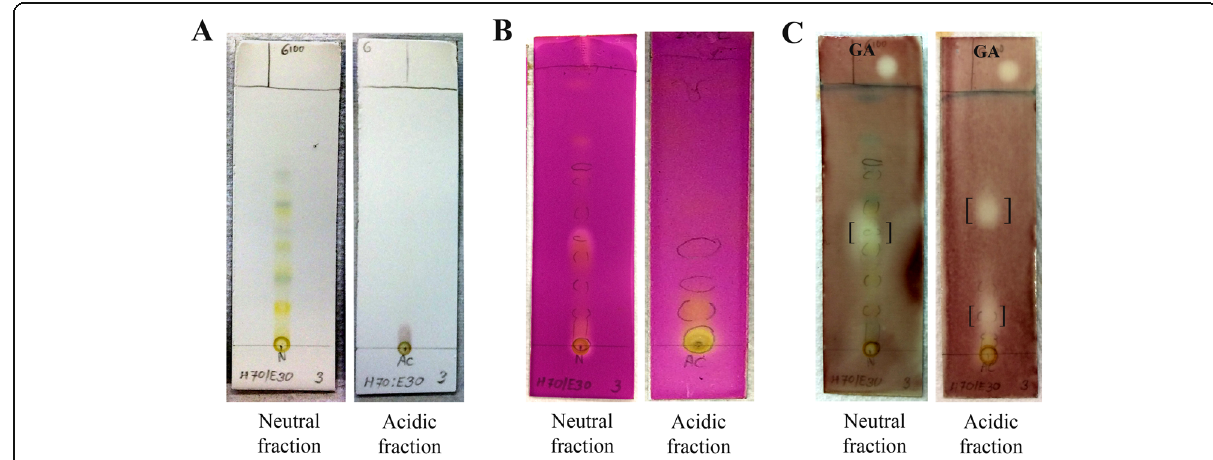
Fig. 5 Anti-AChE activities of neutral and acidic fractions obtained from S. asper leaves. TLC chromatograms of neutral and acidic fractions (at 6.7 μ g application) in a solvent system of hexane:ethyl acetate (7:3, v /v) were observed a under visible light, b by staining with KMnO 4 , and c by bioautographic method for screening on AChE inhibitory activity, where white spots against the dark background represent the inhibition. Galantamine (GA) was used as a positive control at 0.3 μ g. Brackets indicate AChE inhibiting